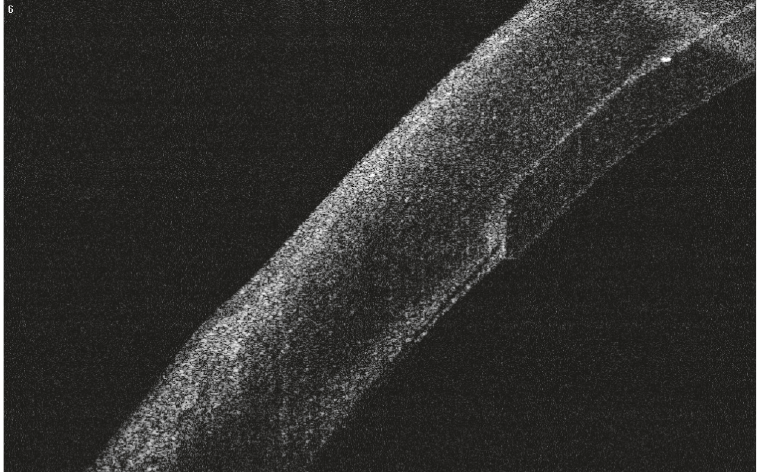
Figure 12: Another good match one month postoperatively after our parameter modi fi